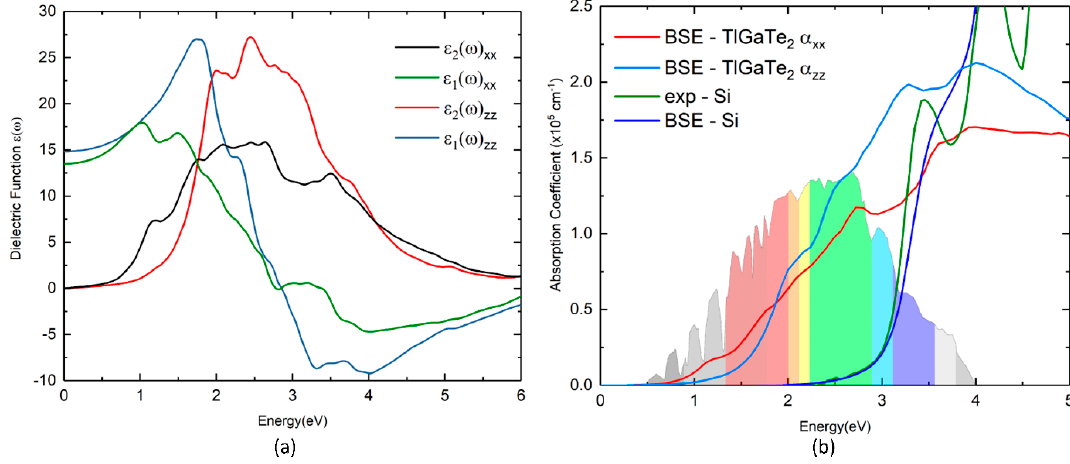
ffi cient of TlGaTe 2 ; ( b ) absorption coe 2